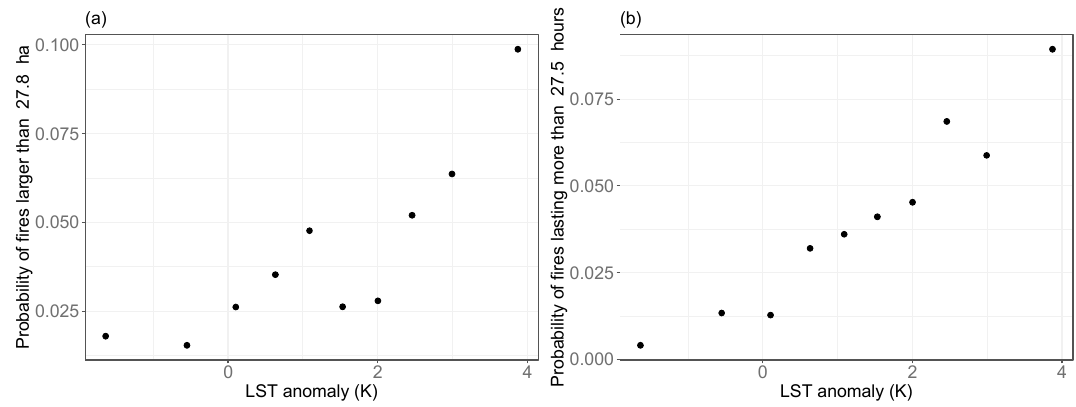
Figure 12. Estimated probability of burned area exceeding 27.8 ha, conditional to LST anomaly values in 10 decile bins ( a ); estimated probability of fire duration exceeding 27.5 h, conditional to LST anomaly values in 10 decile bins ( b ).